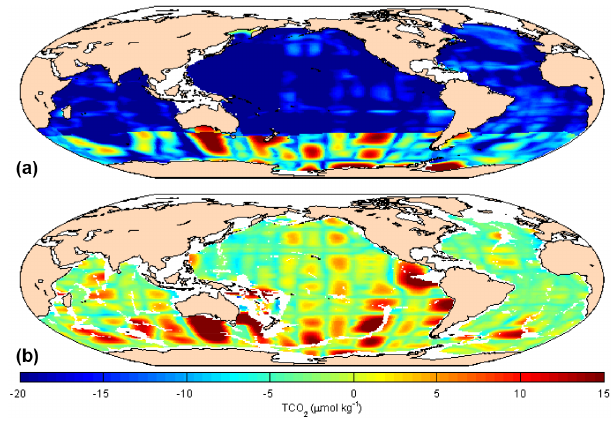
Figure 13. Mapping error for TAlk in GLODAPv2.2016b mi- nus mapping error for TAlk in GLODAPv1.1 at 10m (a) and 3000m (b) . Note that the differences are mainly attributable to dif- ferences in method and not real reductions/increases in mapping error.